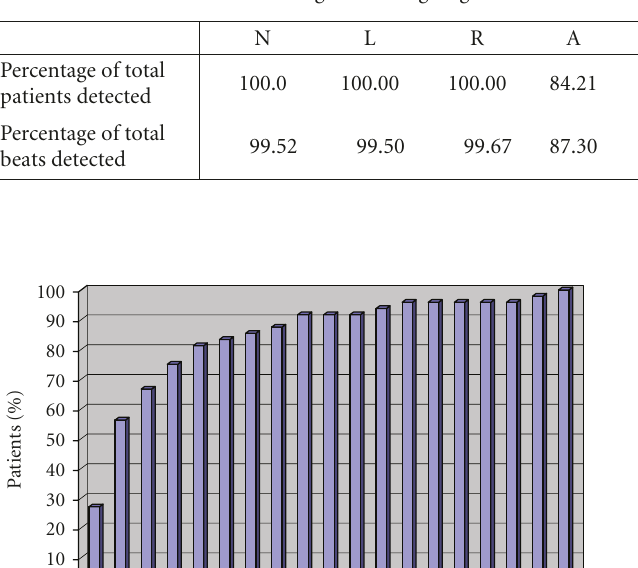
Table 2: Summary comparison of detection through symbolization to cardiologist supplied labels. The labels used correspond to the original MIT-BIH Arrhythmia database annotations (N = normal, L = left bundle branch block, R = right bundle branch block, A = atrial premature beats, a = aberrated atrial premature beats, V = premature ventricular complex, P = paced beat, f = fusion of normal and paced beat, F = fusion of ventricular and normal beat, j = junctional escape beat). The top row is indicative of how well the clustering did at identifying the presence of classes of clinical activity identified by the cardiologists for each patient. The bottom row indicates how well the clustering did at assigning individual beats to the same classes as the cardiologists.